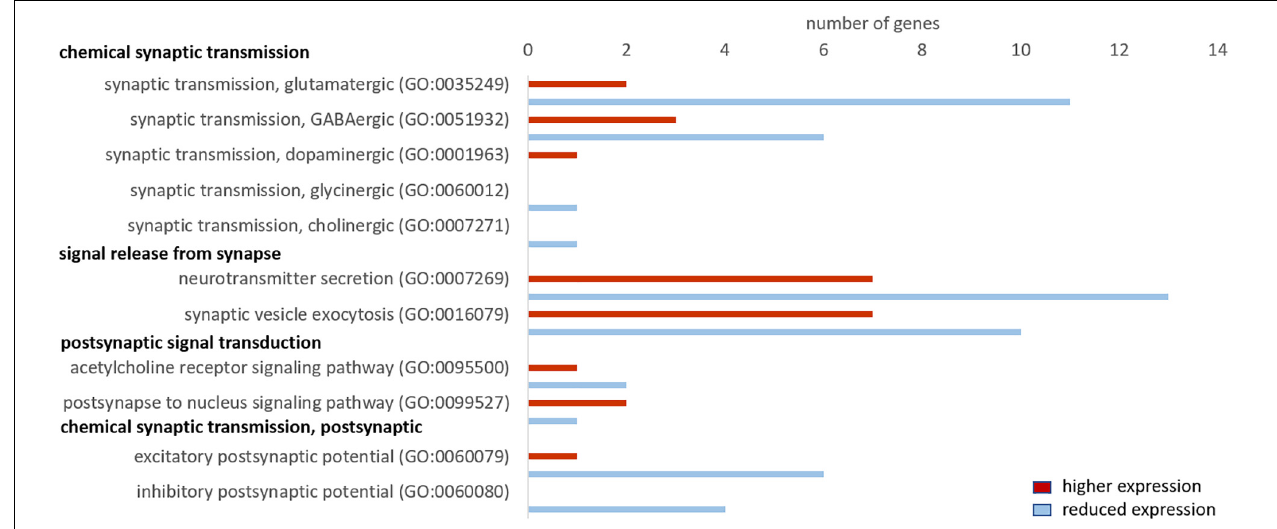
FIGURE 8 | Genes related to neuronal signaling that show a higher (red) and lower expression (blue) in whales compared to cattle. Only genes differentially expressed (fold change ≥ 2, range ≥ 5, RPKM ≥ 1 and FDR-corrected p -value ≤ 0.05) were considered.